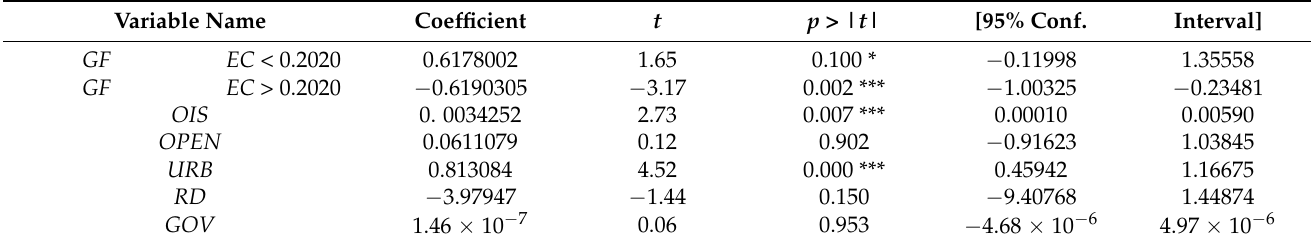
Table 8. Results of DE regression estimation on EC panel threshold